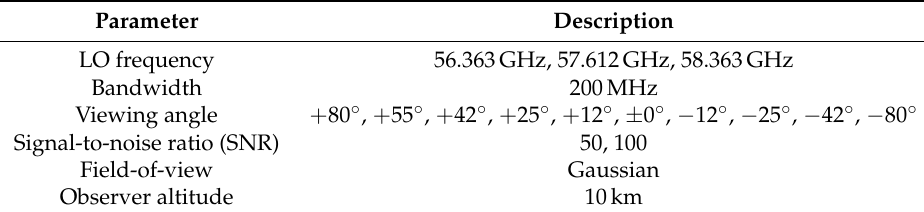
Table 1. The MTP instrument parameters and measurement